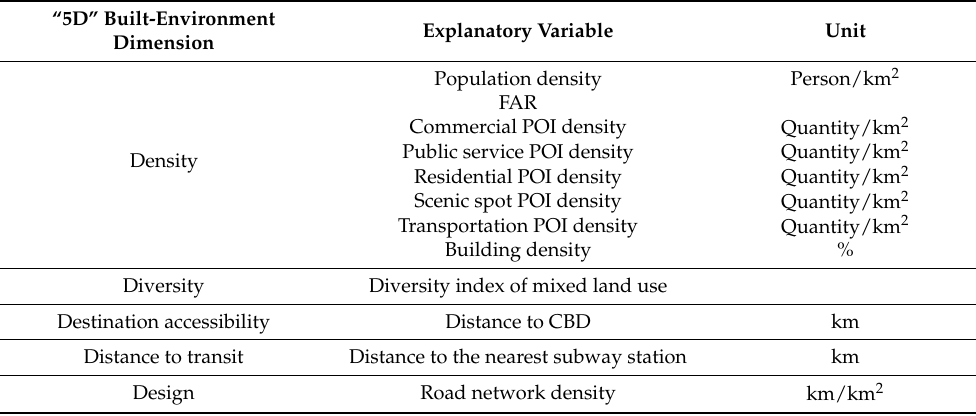
Table 3. Built-environment explanatory